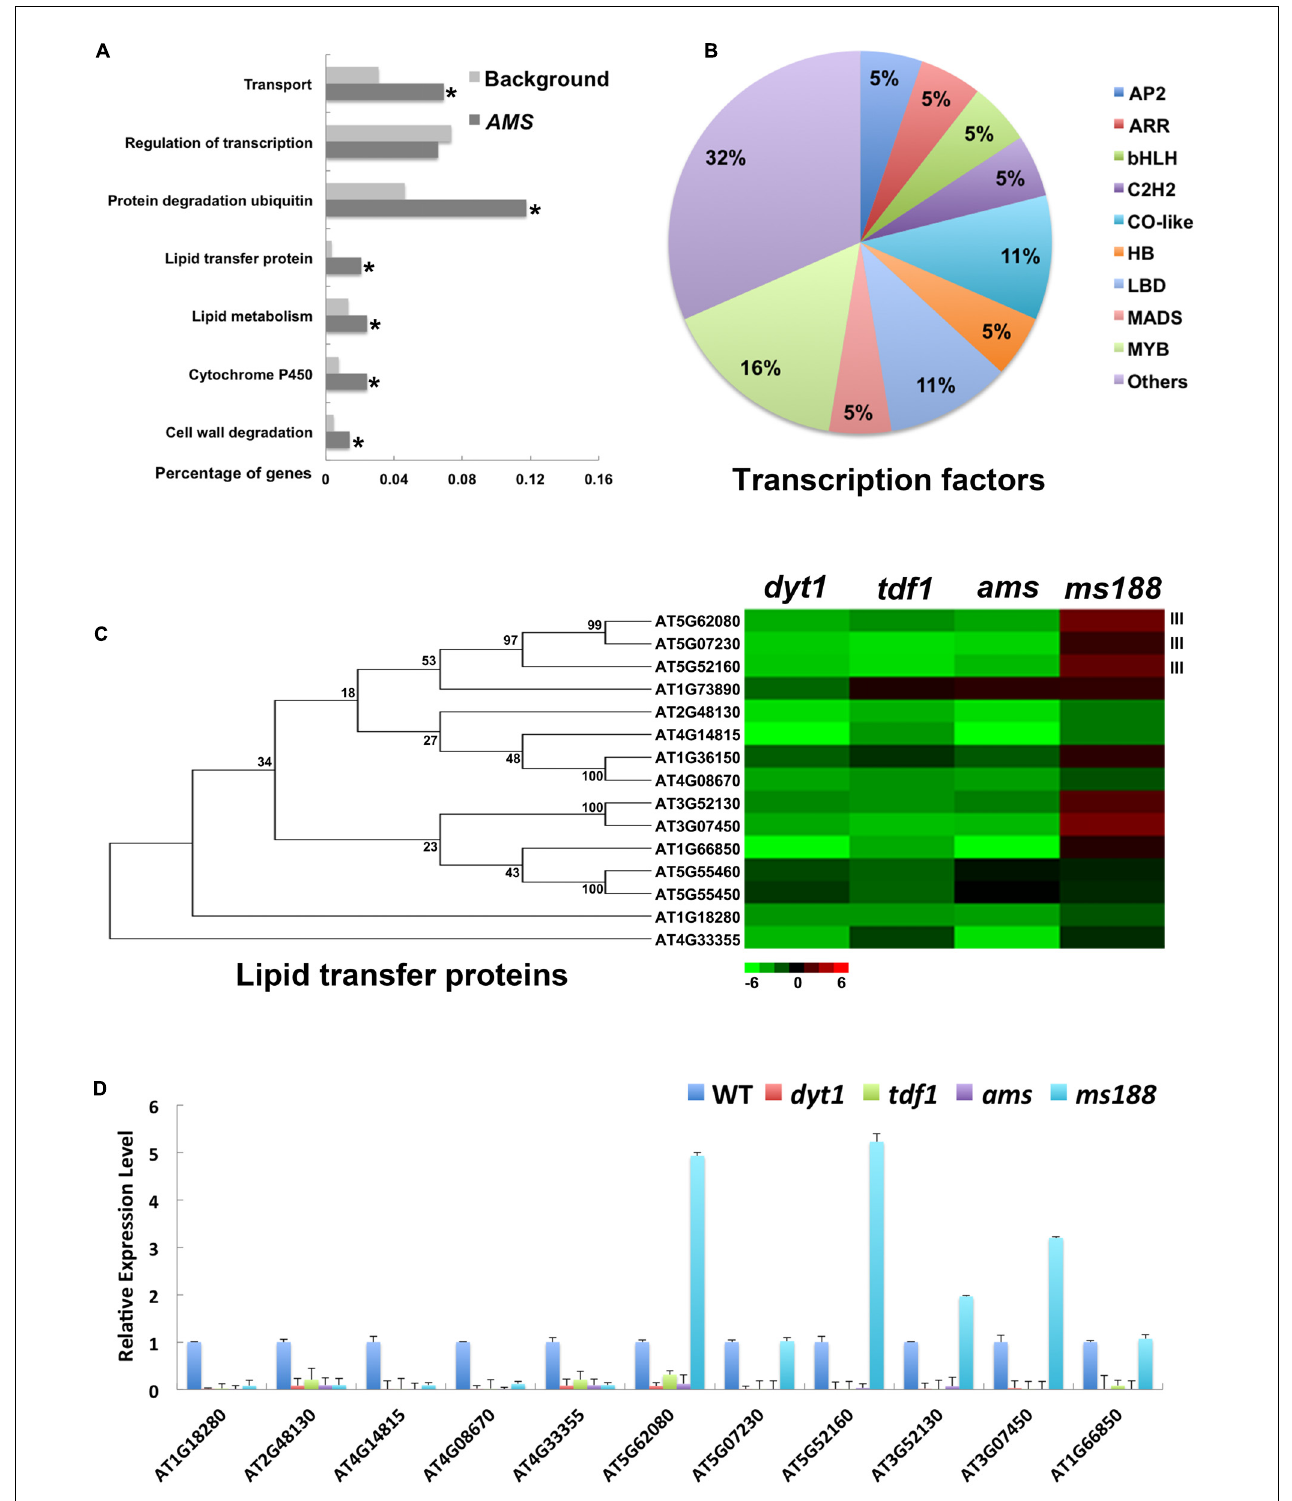
FIGURE 5 | Functional analysis of AMS -specific genes. (A) GO enrichment analysis of AMS -specific genes. (B) Subsets of transcription factors in AMS -specific genes. (C) Heat map of mRNA expression profiles of lipid transfer proteins of AMS in dyt1 , tdf1 , ams , and ms188 mutants. Green and red colors represent lower and higher log 2 fold changes of expression in mutants compared with the wild type. (D) Q-RT-PCR analysis of the lipid transfer proteins. Asterisk indicates P values < 0.05 compared with background.